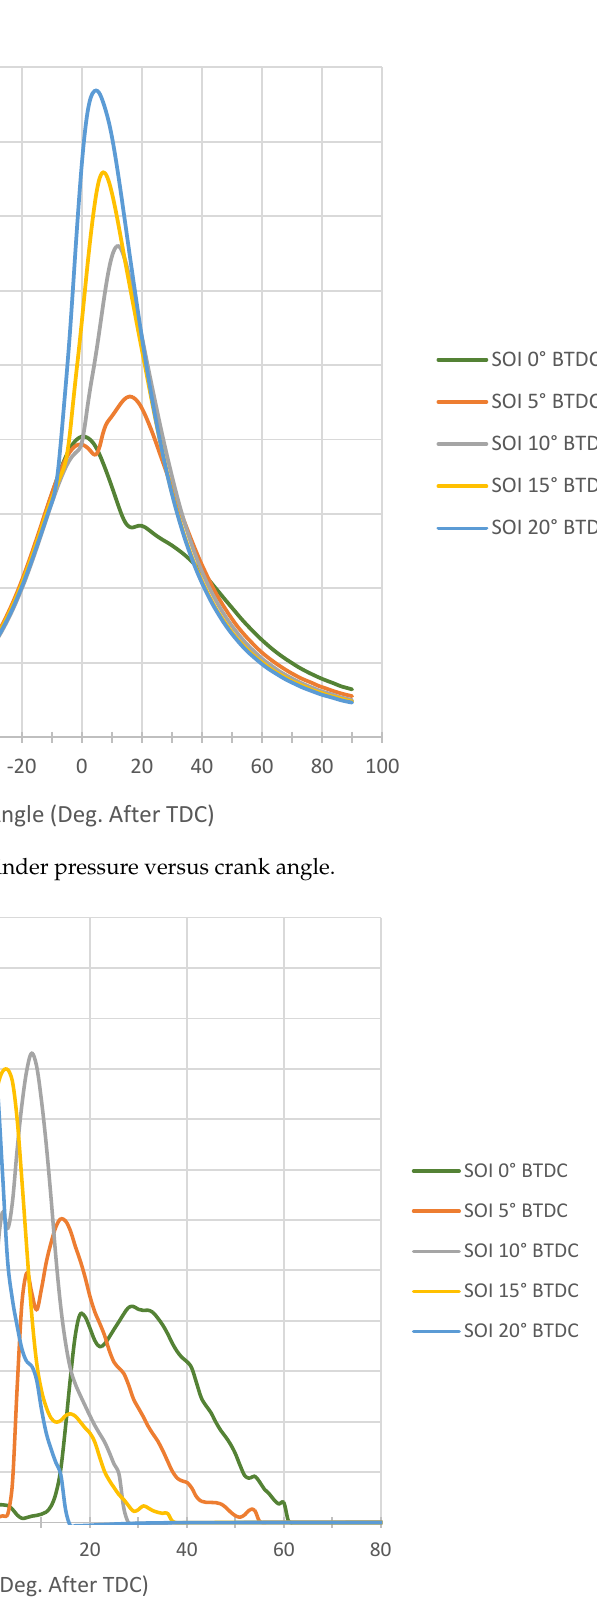
Figure 10. Heat release rate versus crank